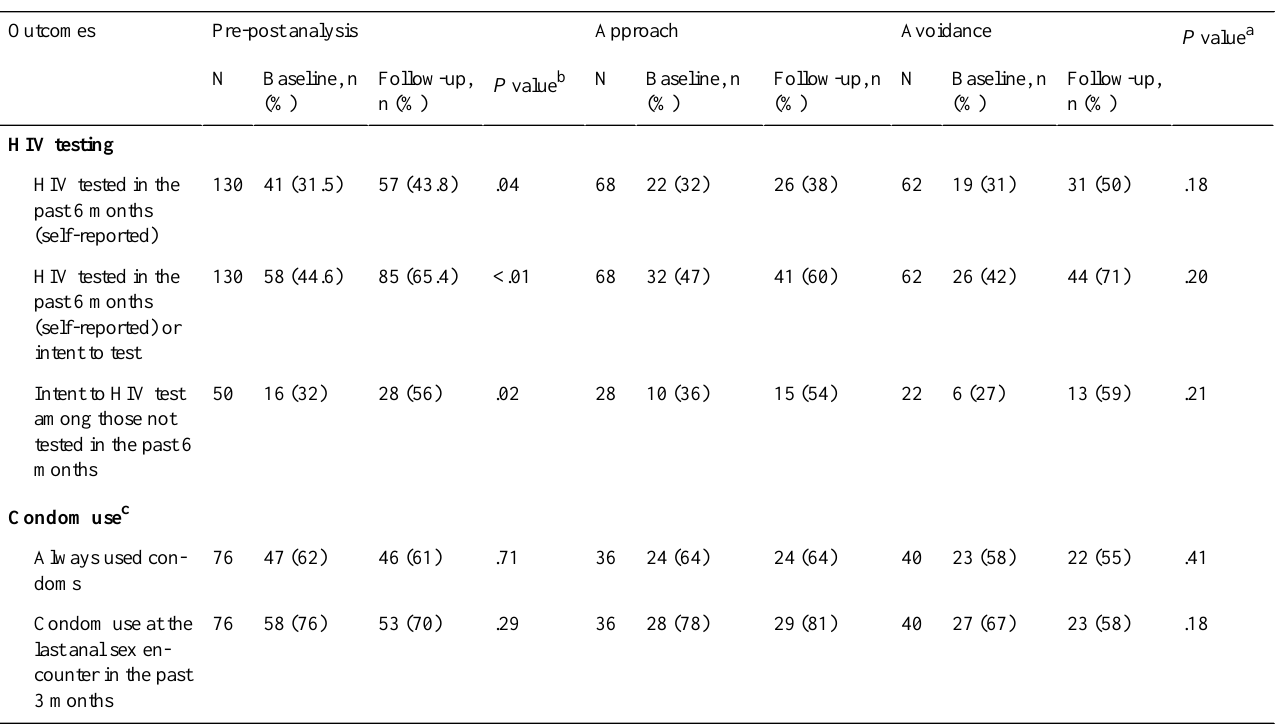
Table 2. HIV testing and condom use at baseline and follow-up.